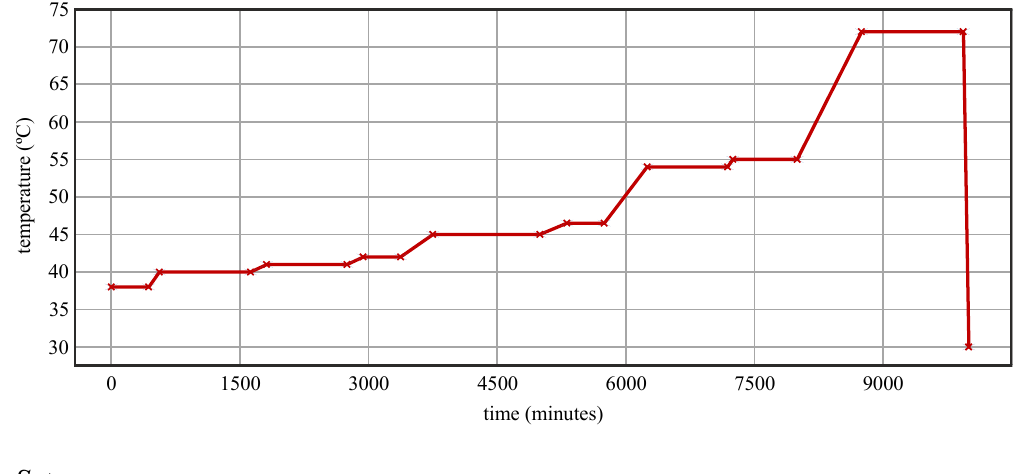
Figure 2. Target temperature evolution in the analysed drying